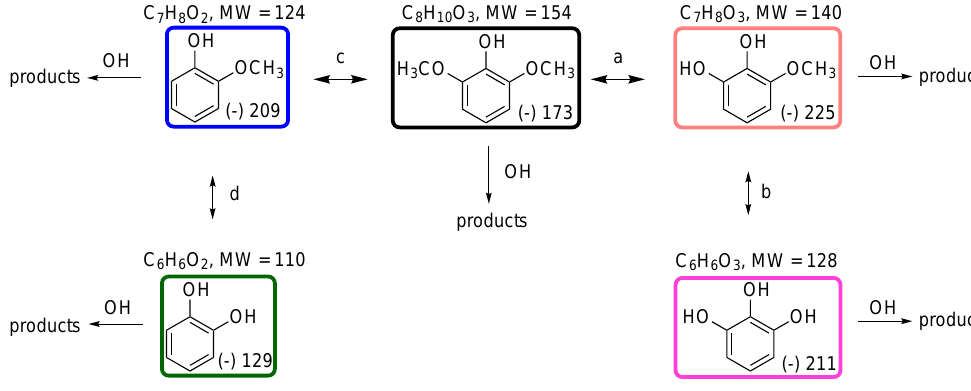
Fig. 8. Possible routes of methoxy loss in syringol gas-phase chemistry.